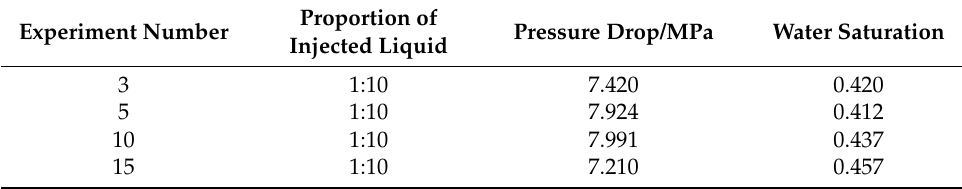
Table 5. Data from repeated